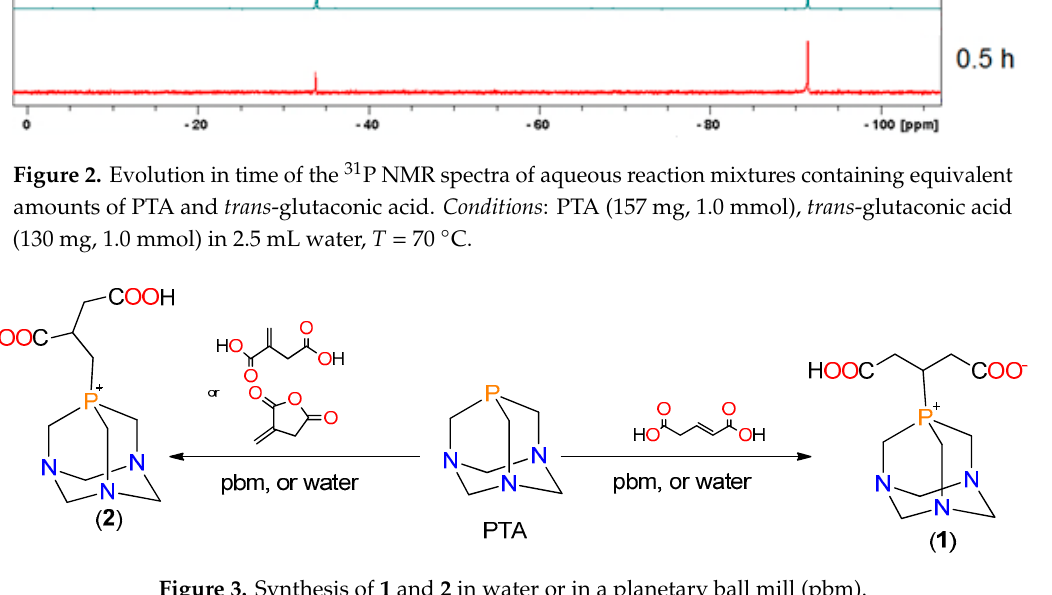
Figure 3. Synthesis of 1 and 2 in water or in a planetary ball mill (pbm).